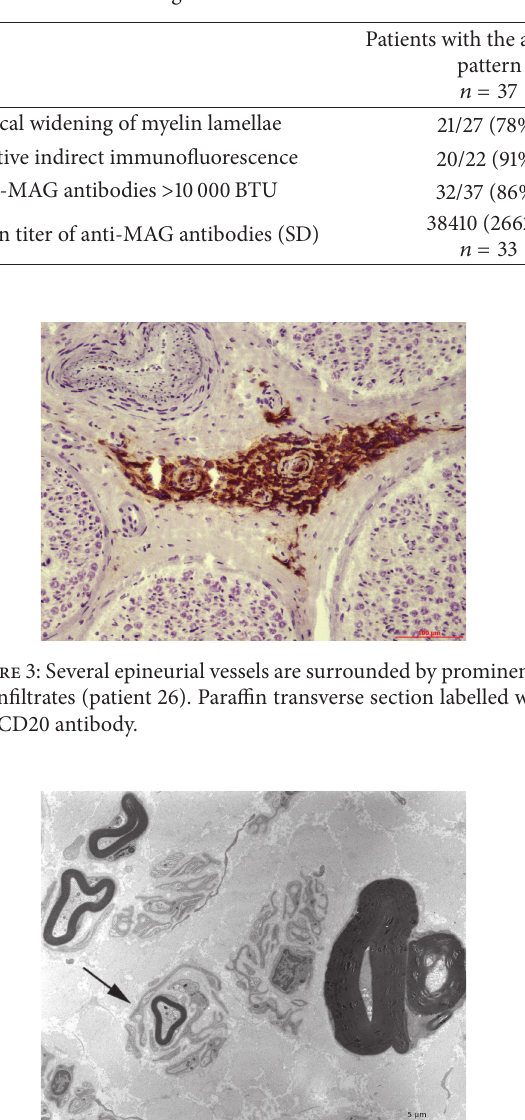
Table 2: Main clinical and laboratory data from 2 subpopulations of patients with polyneuropathy and anti-MAG antibodies according to nerve conduction findings.